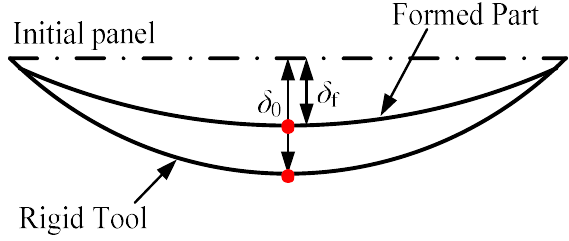
Figure 12. Schematic diagram of springback measurement.